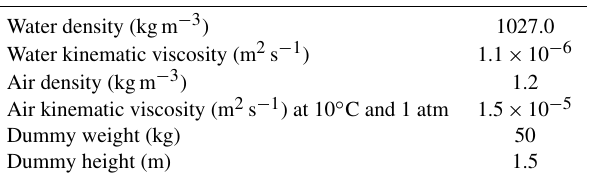
Table 4. Parameters to solve the force balance equation for the dummy in the Sicilian